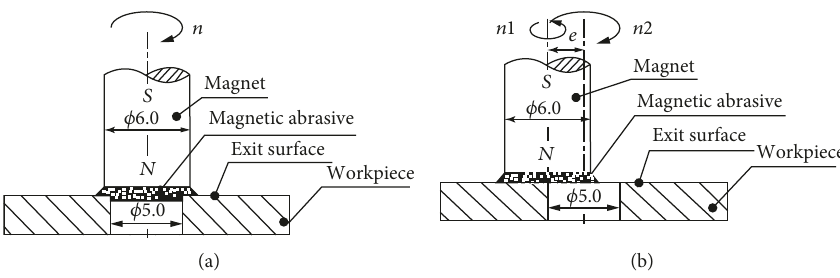
Figure 6: The principle comparison of the two plans (Plan 1 (a) and Plan 2 Table 9: Process parameters of the two plans.